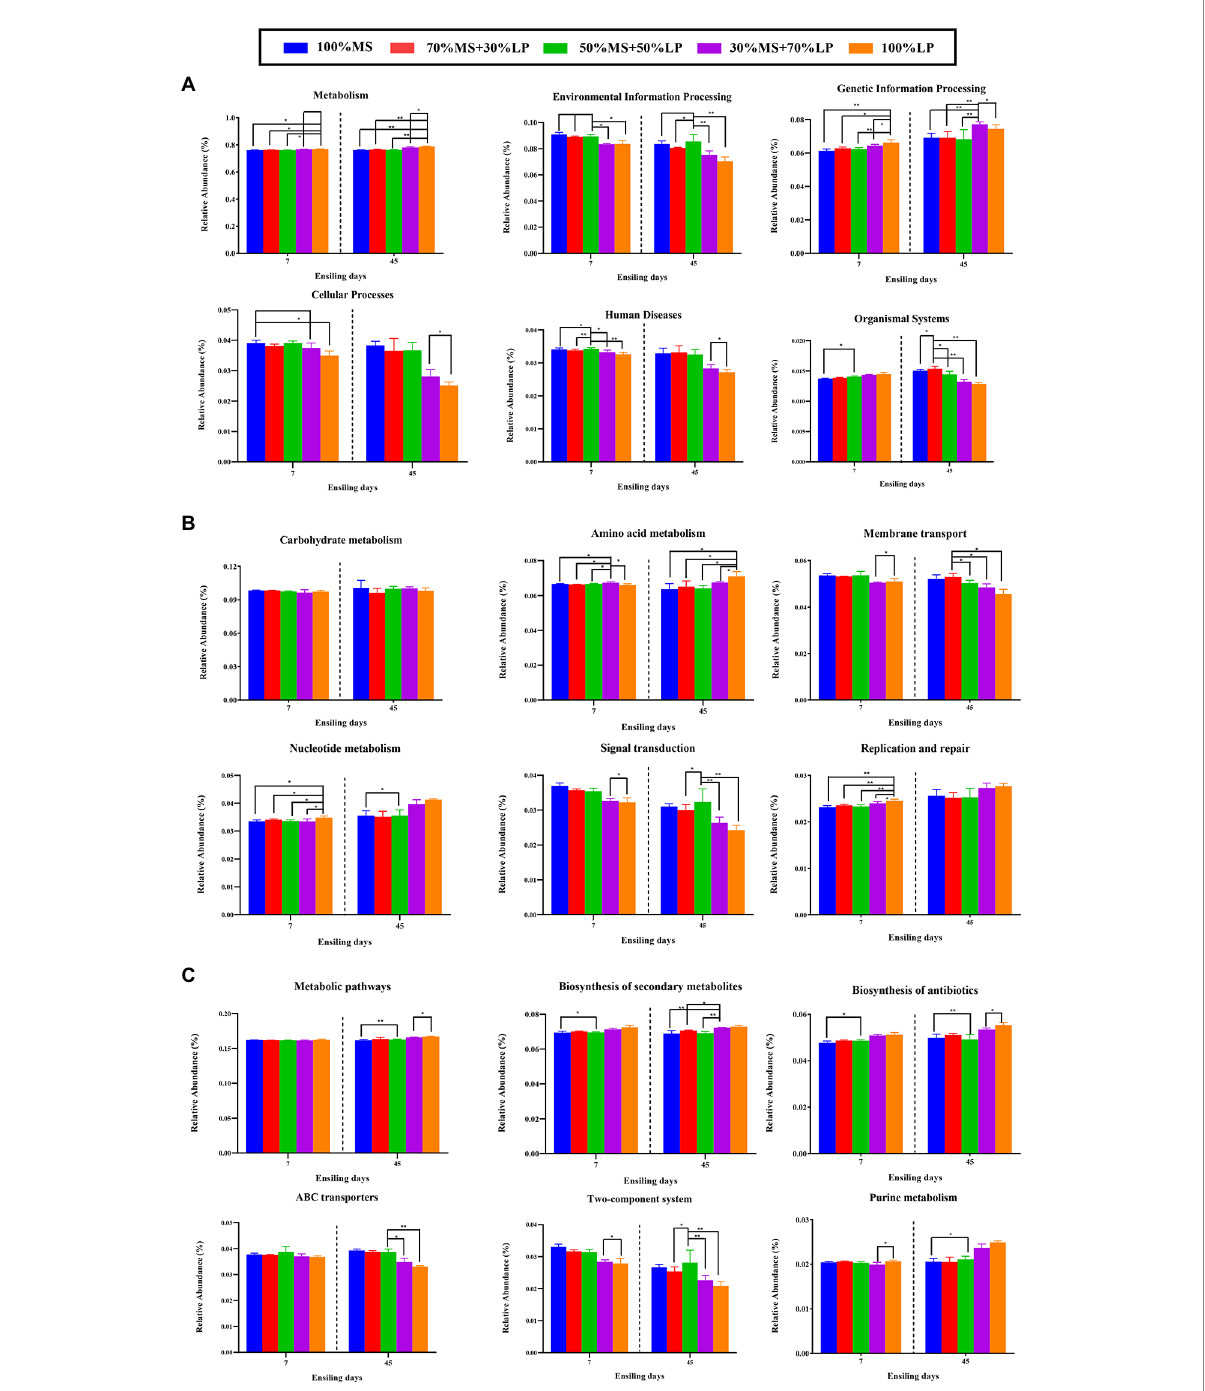
FIGURE 4 Bar graphs showing 16S rRNA gene-predicted functional profiles on the level 1 metabolic pathways (A) , level 2 metabolic pathways (B) and level 3 metabolic pathways (C) of silages for 45 days obtained with Tax4Fun. 100% MS, 100% alfalfa; 70% MS + 30% LP, 70% alfalfa+30% perennial ryegrass; 50% MS + 50% LP, 50% alfalfa+50% perennial ryegrass; 30% MS + 70% LP, 30% alfalfa+70% perennial ryegrass; 100% LP, 100% perennial ryegrass. ∗ , 0.01 < p < 0.05; ∗∗ , 0.001 < p <